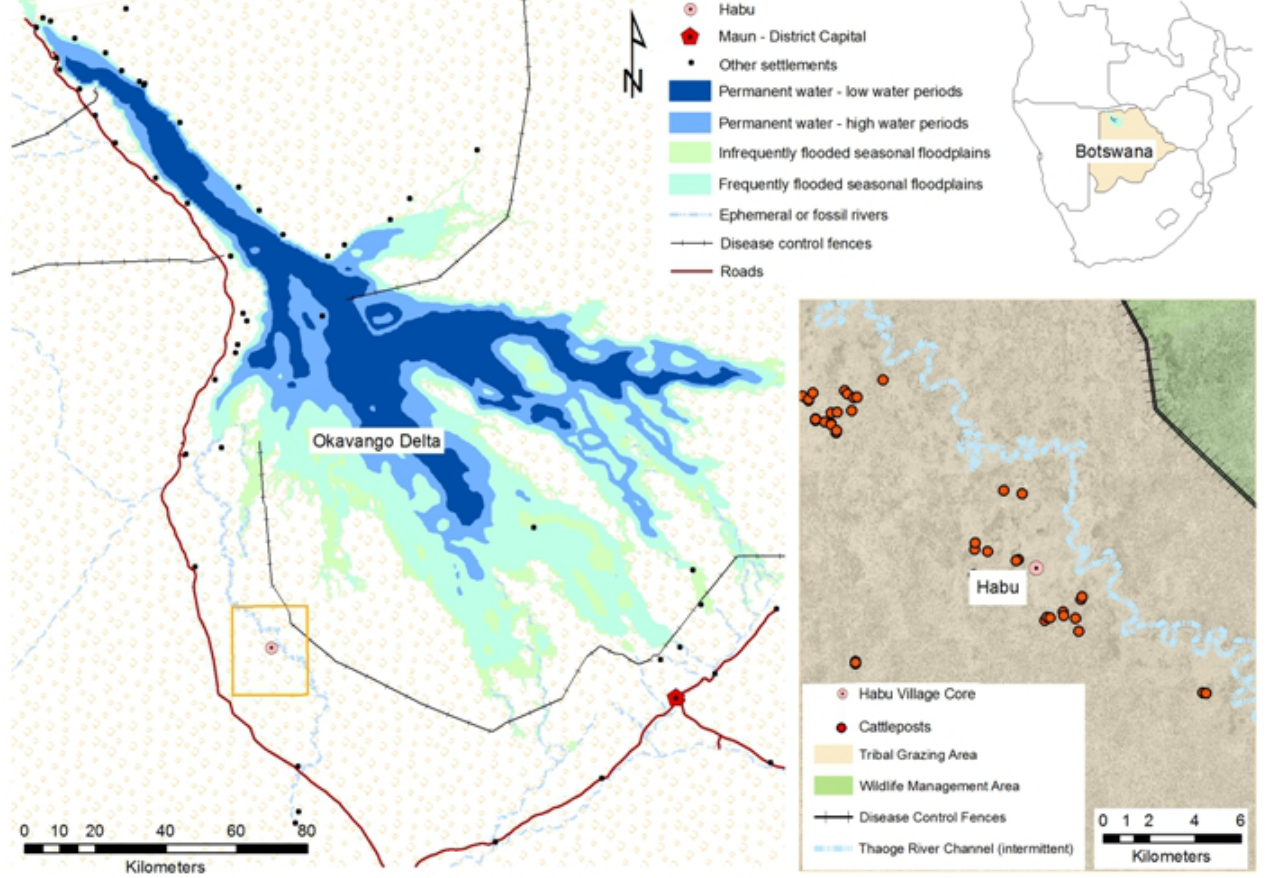
Note: Darker shades in the inset map indicate scrub and woodland, whereas lighter shades show old floodplains dominated by